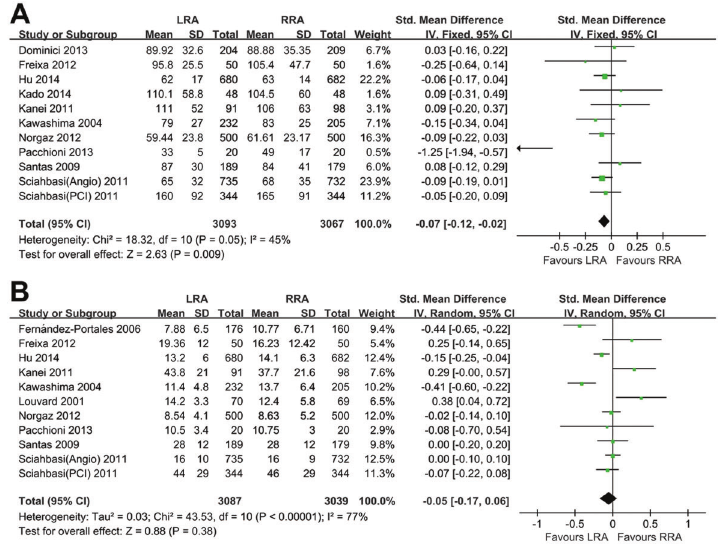
Figure 3. Meta-analysis of secondary outcomes. A , Comparison of the left radial approach (LRA) versus the right radial approach (RRA) for contrast volume. B , Comparison of the LRA versus the RRA for procedural time. In the study of Sciahbasi (13), we reported the meta-analysis results of percutaneous coronary intervention (PCI) and diagnostic angiography (Angio). See